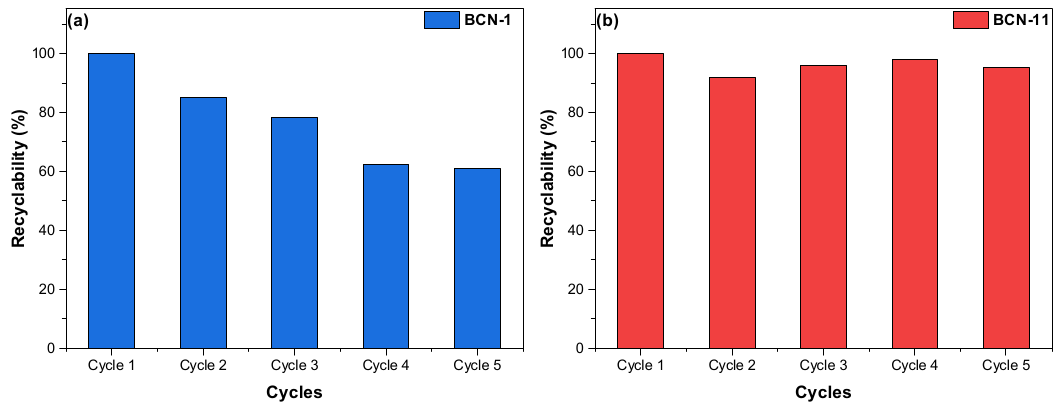
◦ C of ( a ) BCN-1 and ( b ) BCN-11. Figure 8. CO 2 recyclability at 25 °C of ( a ) BCN ‐ 1 and ( b ) BCN ‐ 11. Figure 8. CO 2 recyclability at 25 In order to capture CO 2 , from either air or flue gas, the selectivity for CO 2 adsorption as opposed to N 2 represents a key factor for these targeted applications. Figure 9 shows the adsorption isotherms of both N 2 and CO 2 at 25 ◦ C. One can see that the amount of CO 2 adsorbed was much higher than that of N 2 in any pressure range. This was further confirmed by the calculation of the selectivity value based on the IAST method for flue gas composition evaluated to be equal to 26 for BCN-11. However, since the N 2 adsorption for BCN-1 at 25 ◦ C is too low, it leads the selectivity equation to diverge to infinity based on a null value of q 2 , which is considered insignificant. This falls under the category of the theory’s limitations, when working at low pressure [60].